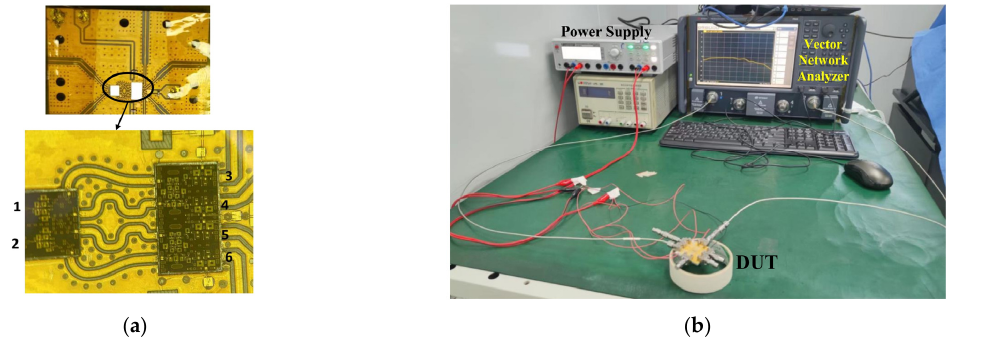
Figure 9. The test fixture and measurement site of the six-port circuit: ( a ) The test fixture, ports 1 to 2 are input ports and ports 3 to 6 are output ports; ( b ) The measurement site.